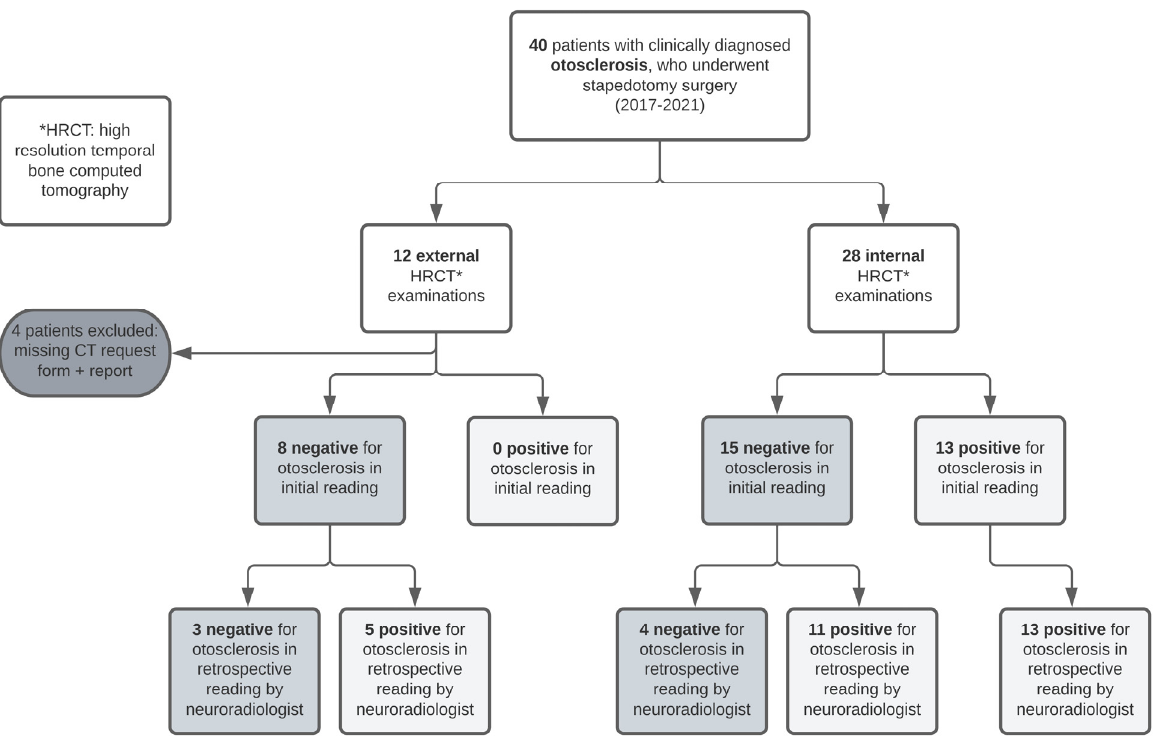
Figure 1. Flowchart summarizing the results of the initial readings by internal and external general radiologists as well as the second readings of the neuroradiologist.